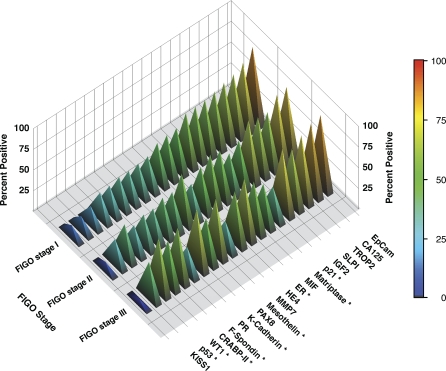
Biomarker Expression Rates in the Entire Cohort by Stage*Significant differences between categories (Fisher's exact test).